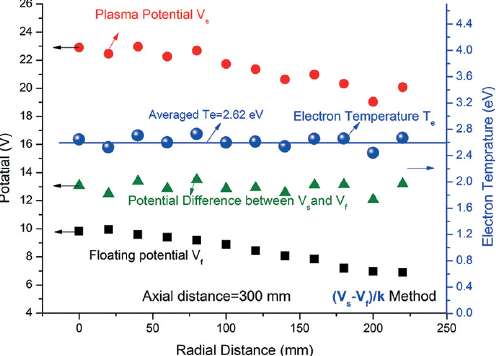
Figure 12. The measured plasma potential, floating potential, and electron temperature by the Langmuir probe for the LIPS-200 ion thruster